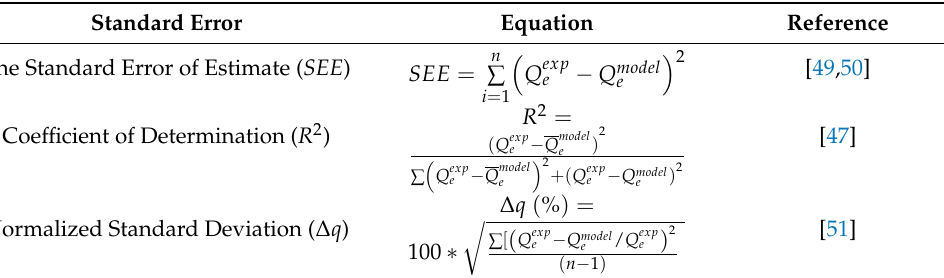
Table 2. List of error